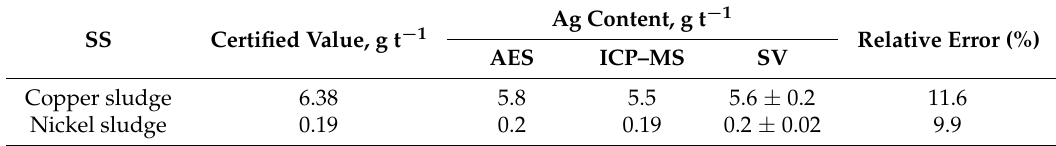
Table 1. Results of stripping voltammetry (SV) determination of silver(I) in standard samples (SS) of copper and nickel sludge analyzed by different methods ( n = 5, P = 0.95).